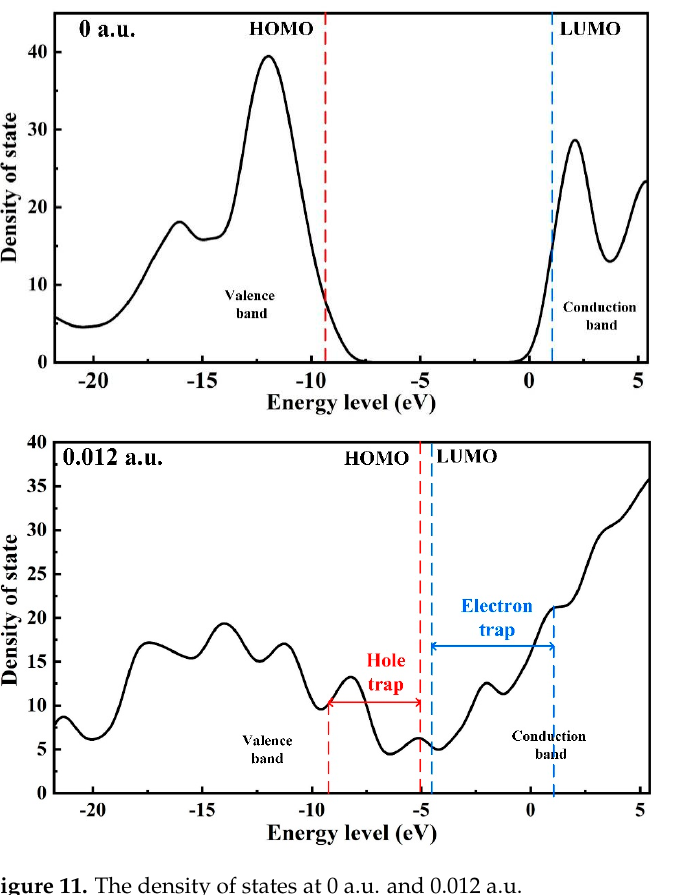
Figure 11. The density of states at 0 a.u. and 0.012 a.u.